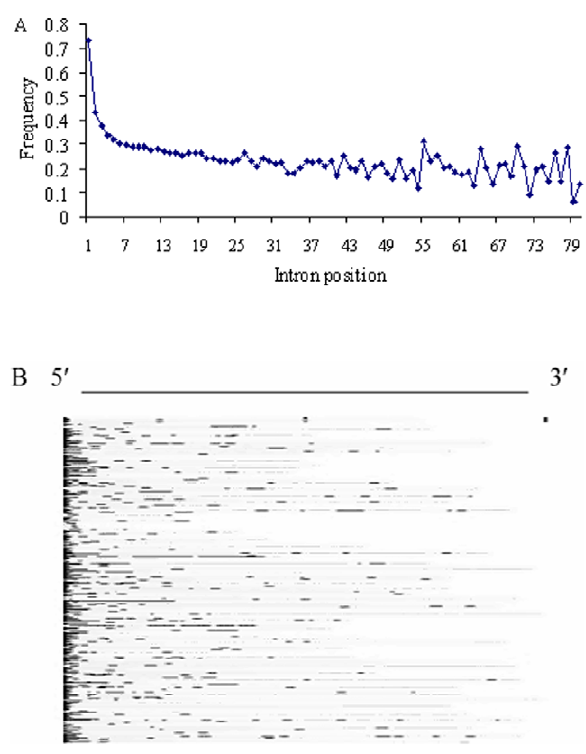
Figure 3. CpG island in the introns. (A) Frequencies of introns containing CpG islands at different positions. (B) Locations of CpG islands in the first introns. 500 introns are selected randomly from the first introns. The CpG islands are represented as black lines in the first introns where other regions are represented as gray spaces. The sequence direction is from 5 9 -ends to 3 9 -ends of the first